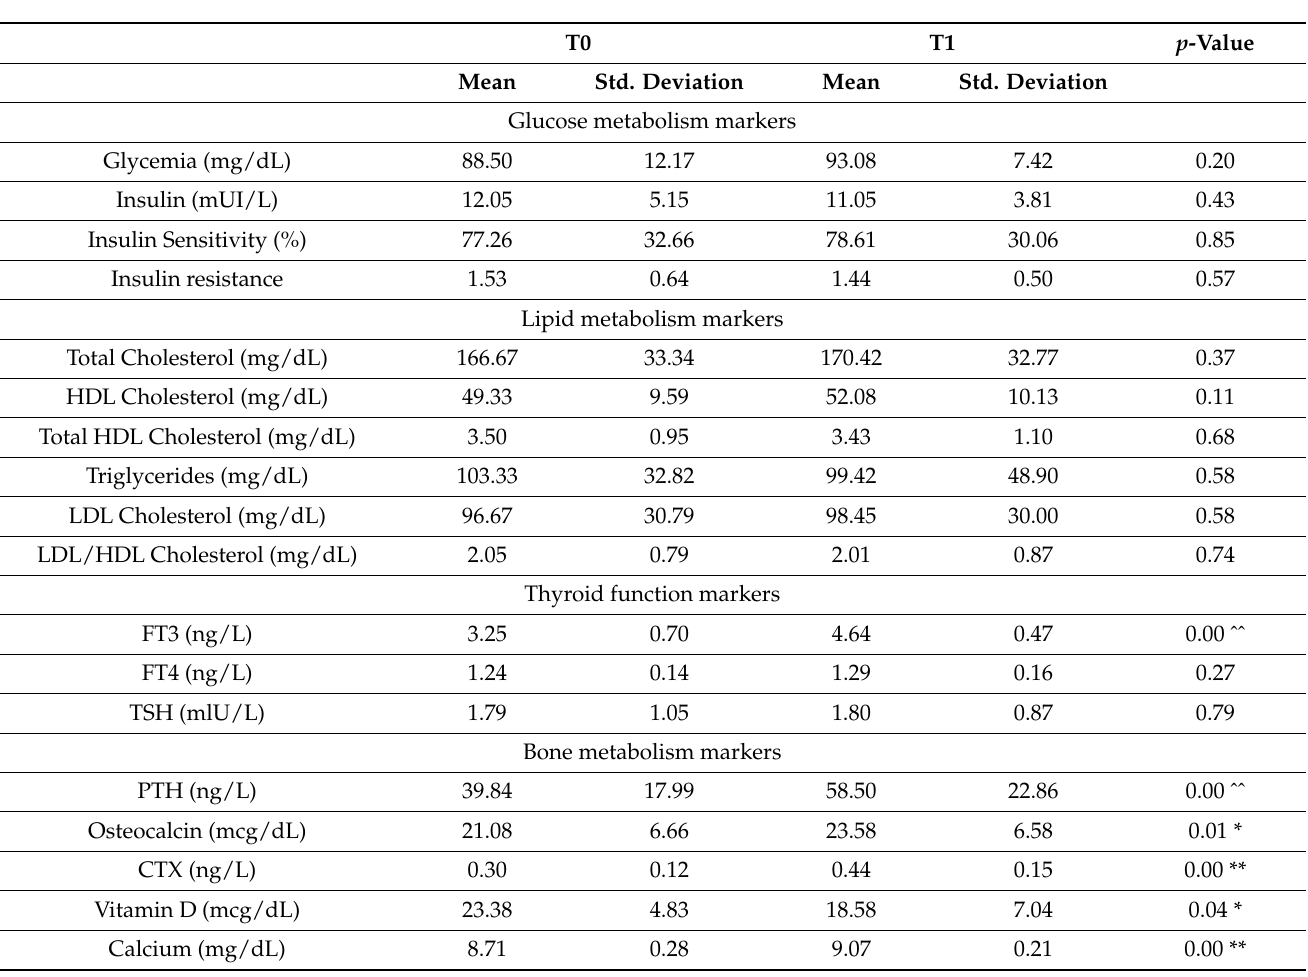
Table 4. Values of glucose metabolism, thyroid function, and bone metabolism markers at baseline and after 11 weeks of training. Blood samples were collected at time 0 (baseline) and at the end of the 11 weeks